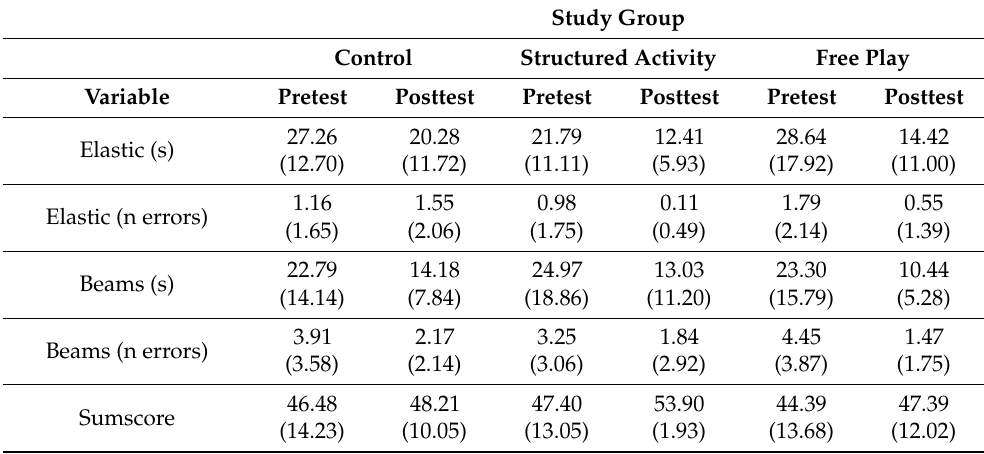
Table 3. Results (means, SD) from playground-specific tests at pretest and posttest across study